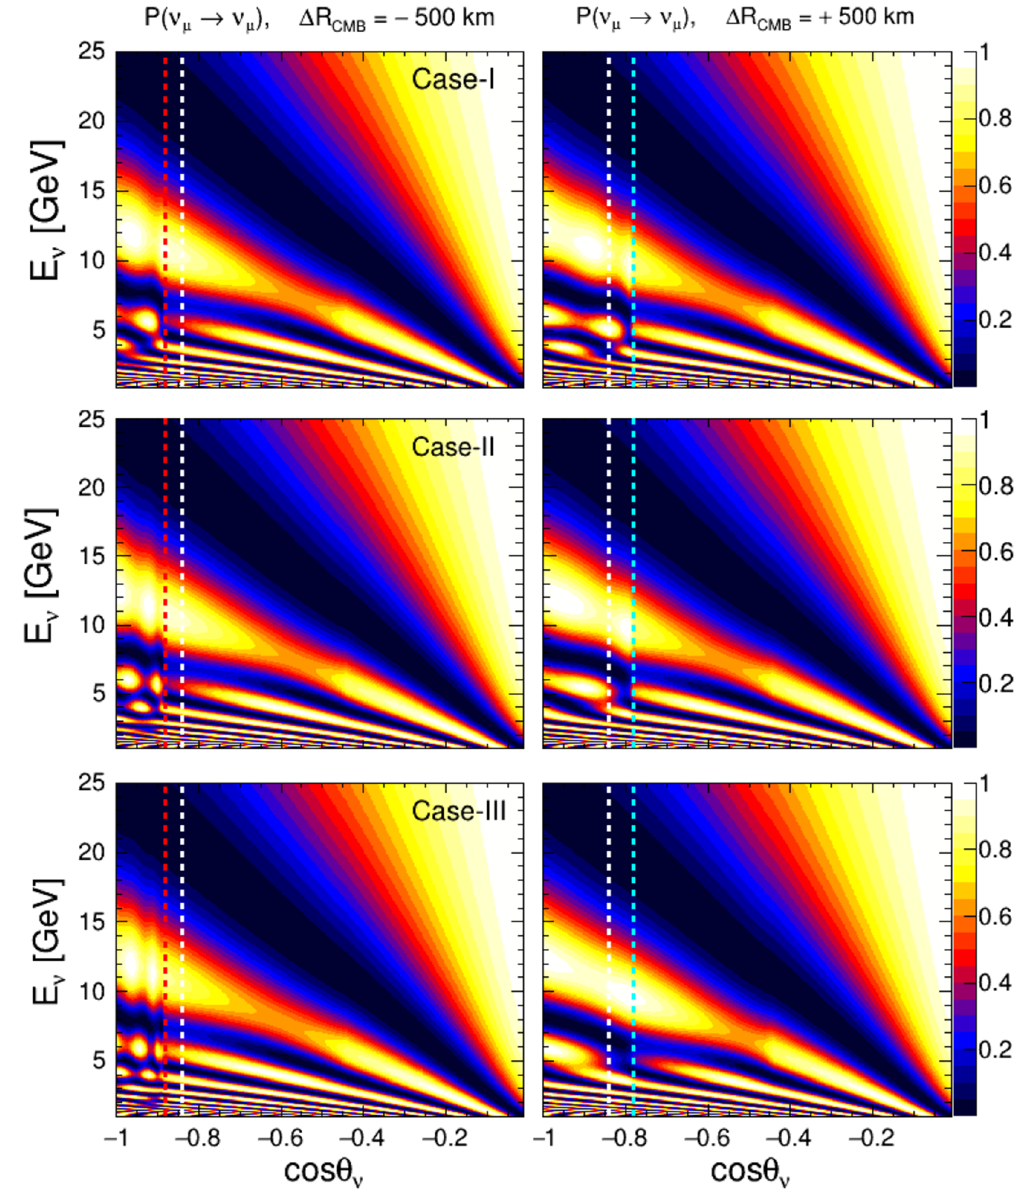
Figure 5 . Three-flavor ν µ → ν µ oscillograms for the three-layered profile of Earth with modified R CMB . The left (right) panel is for SC (LC) with ∆ R CMB = − 500 km ( +500 km). The white, red, and cyan vertical dotted lines correspond to the standard, smaller, and larger R The top, middle and bottom panels correspond to the Case-I, Case-II and Case-III, respectively. We use three-flavor neutrino oscillation parameters given in table 2, where we assume NO and sin 2 θ = 23